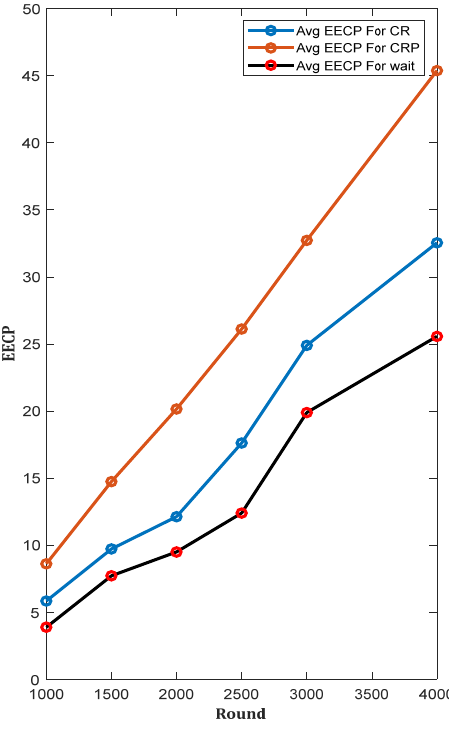
Figure 11. EECP vs. round.